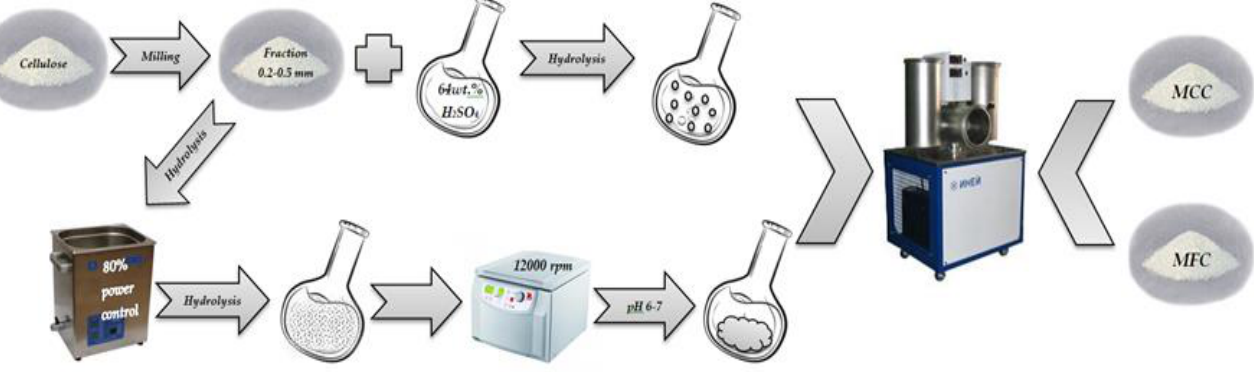
Figure 2. Scheme of the process obtained of the MCC and MFC.